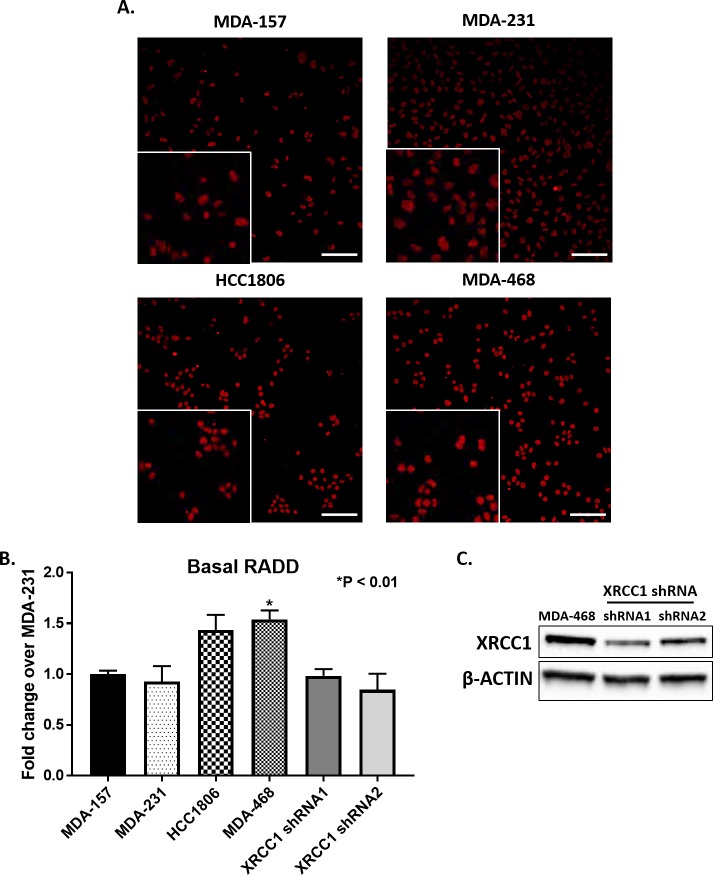
Basal DNA damage in TNBC cell lines.A) Representative images of basal levels of DNA damage as measured by RADD in MDA-157, MDA-231, HCC1806, MDA-468 with insets showing blown up cropped images. Scale bar = 100 μm. B) Quantification of images in A normalized to MDA-231 show an increase in DNA damage in HCC1806, and a significantly higher amount (P < 0.01, MDA-468 to MDA-231) of DNA damage for MDA-468. MDA-468 cells with XRCC1 knockdown show decreased levels of basal DNA damage. C) Expression of XRCC1 in MDA-468 and MDA-468 XRCC1 knockdown cells.